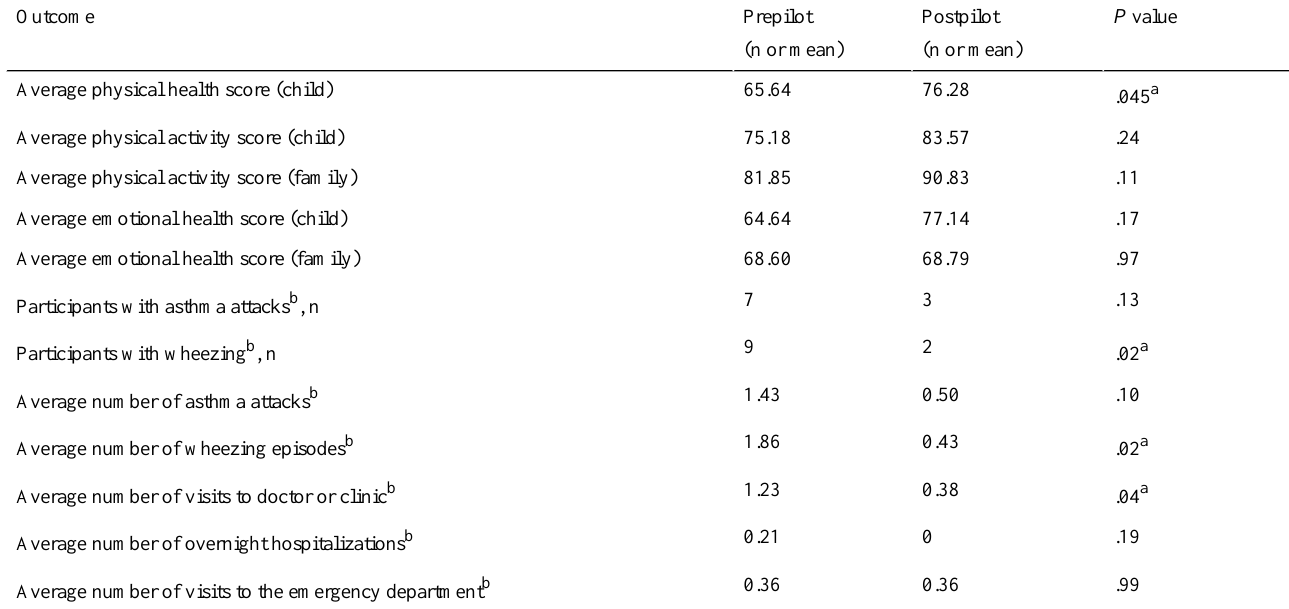
Table 3. Asthma outcomes among pilot program participants who completed preintervention and postintervention Children’s Health Survey for Asthma (CHSA) surveys (n =